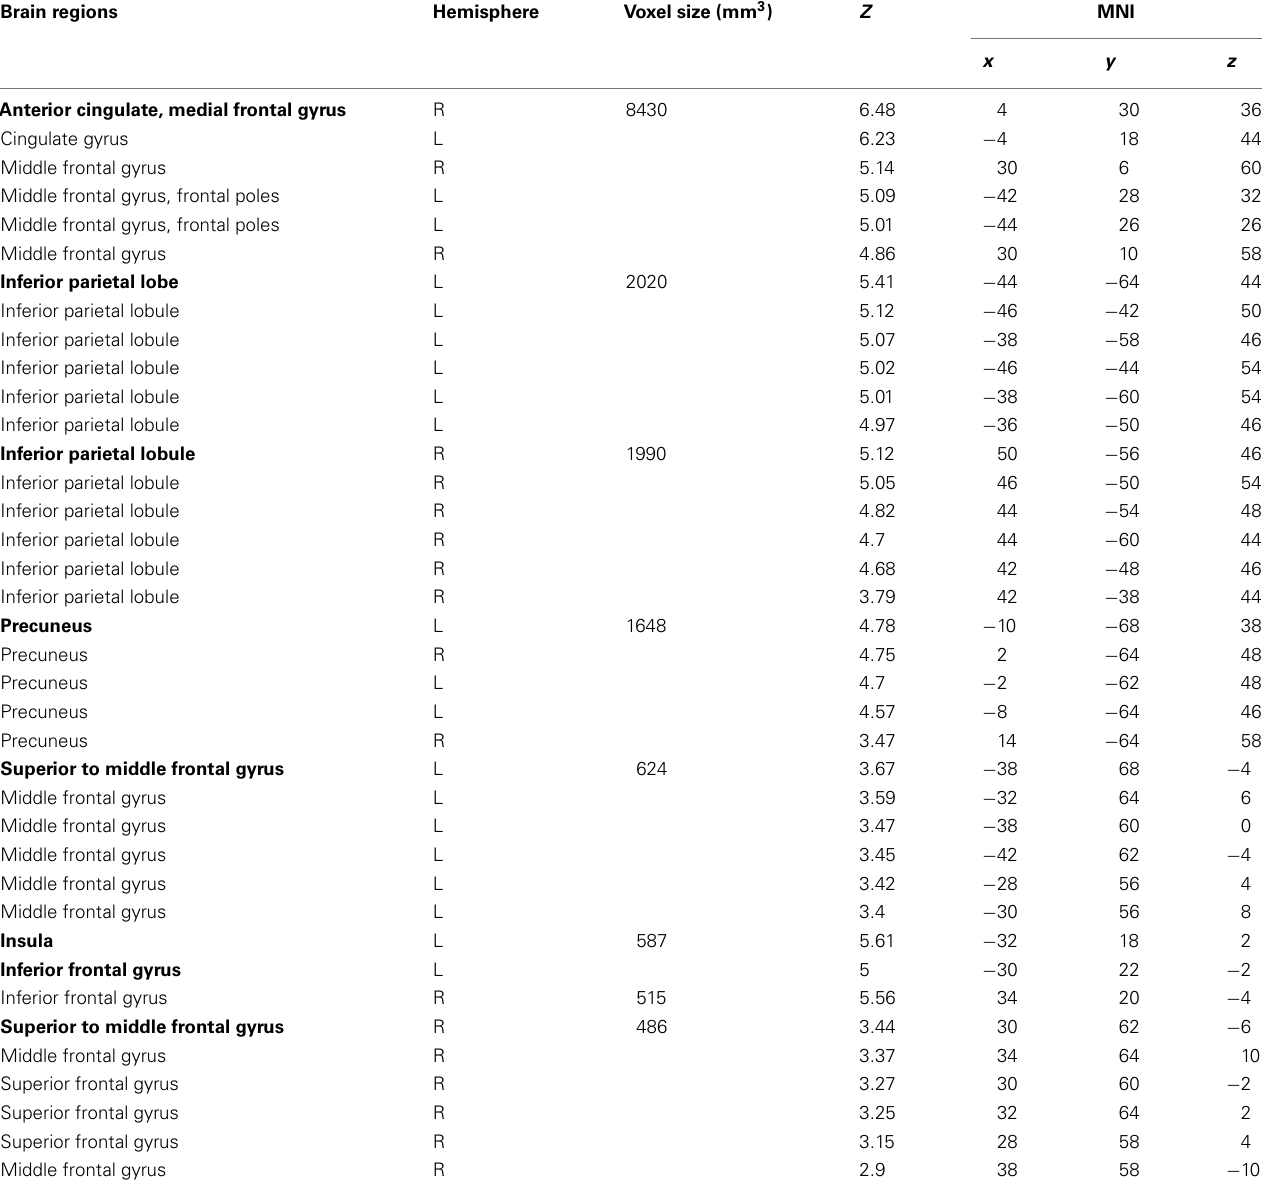
Table 1 | Cluster and subcluster activations for the decision phase: behavioral risk > (no risk + reward risk). Brain